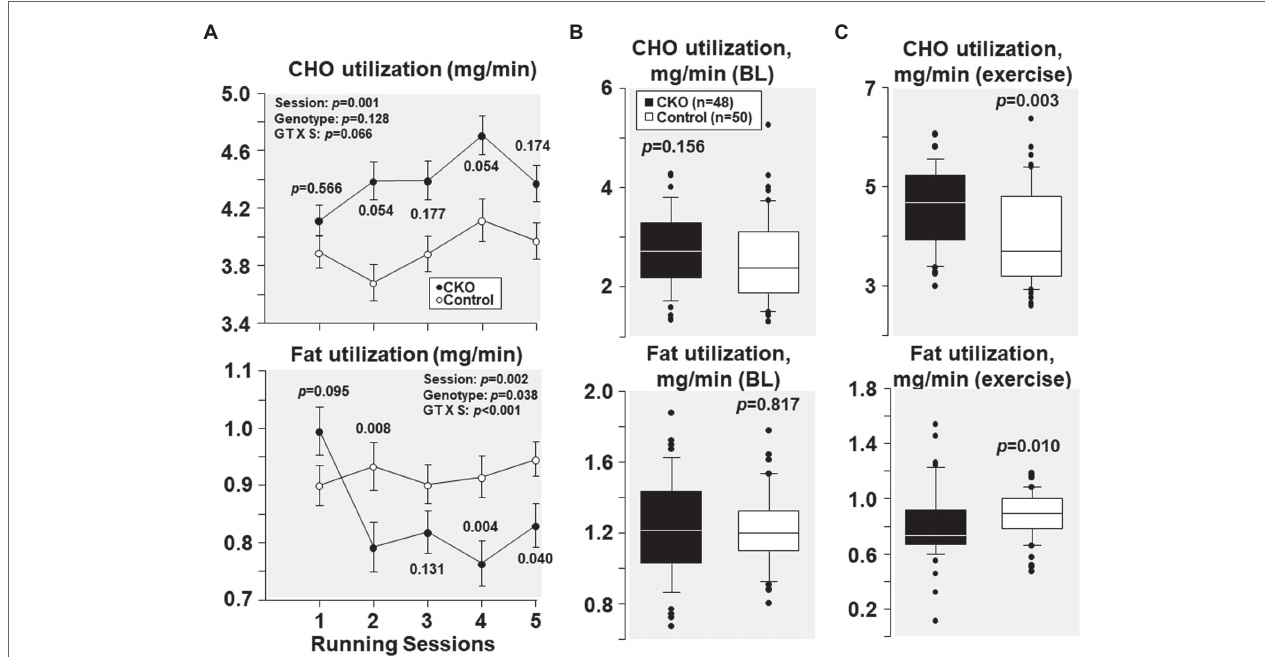
FIGURE 4 | (A) Carbohydrate (CHO) and fat utilization at five running sessions by conditional cyclophilin-D knockout (CKO; n = 10) and control mice ( n = 10). Differences were analyzed by a linear mixed-effects model. Data from one CKO mouse were lost at running session four and five due to refusal of running. (B) Box plots depicting estimation of carbohydrate and fat utilization by conditional cyclophilin-D knockout (CKO) and control mice at baseline (BL) and (C) during exercise (all individual data points of all five running sessions). Differences were analyzed by t-test when normality test passed (CHO utilization) and by Mann-Whitney Rank Sum test when normality test failed (Fat utilization).